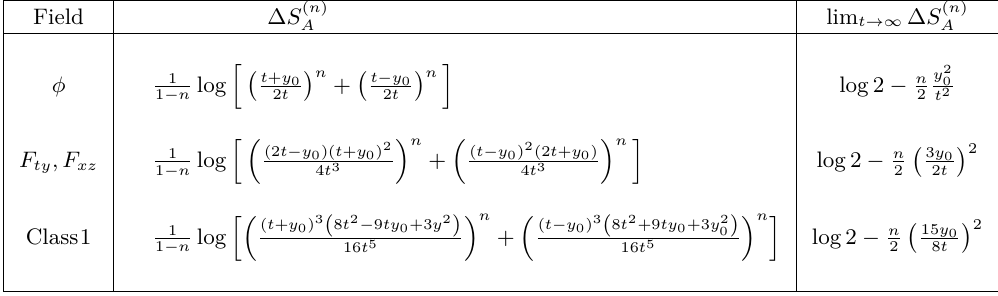
Table 1 . Rényi entropy growth of scalars under SO(2) T × SO(2) L . The last column contains the asymptotic behavior of Rényi entropy after the quench enters the entangling region. We have combined the scalars under SO(2) T × SO(2) L created by quenches for fields ≤ 2 . Note that the order of the polynomial in r = y 0 /t , which determines the Rényi entropy is 2 s + 1 and the power of the factor (1 + r ) is s + 1 or the dimension of the operator creating the quench. Class 1 contains the curvature components R tyty , R zxzx , R tyzx . This polynomial for the scalars SO(2) T × SO(2) L is completely determined by the spin of the field.